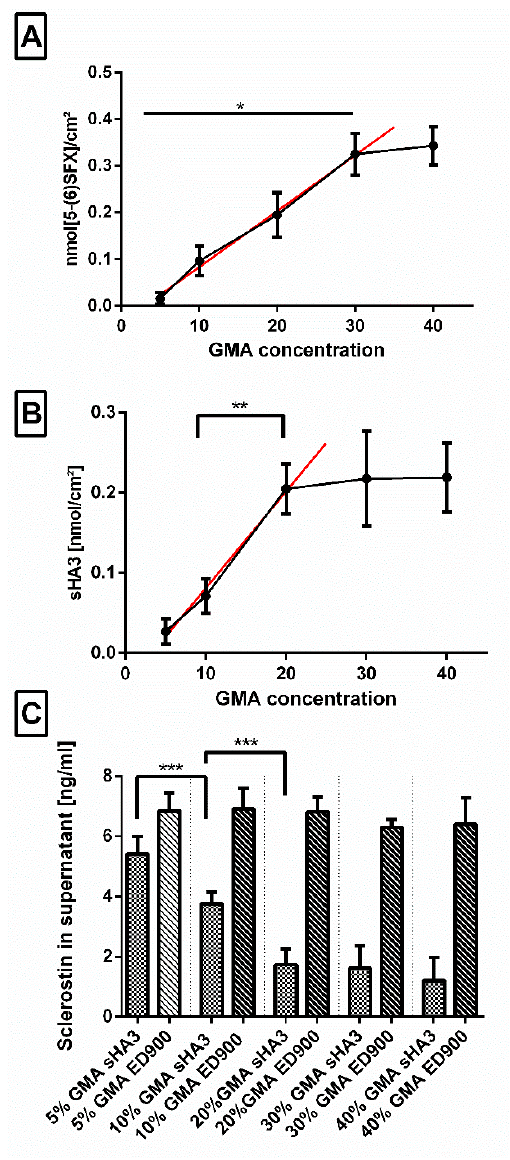
Figure 7. Effect of increasing concentrations (5–40% m/m ) of GMA anchor incorporated during cross- copolymerization. Impact on ( A ) linker surface decoration, measured via 5-(6)SFX staining, ( B ) subsequent functionalization with fluorescent-labeled sHA3, and ( C ) scavenging capability of the sHA3 and ED900 control surfaces is shown. Film surfaces: ED900: ED900 incubated with soluble sHA3; sHA3: ED900 covalently coated with sHA3. Linear regression ( A ) R 2 = 0.92, slope = 0.011, y -intercept = − 0.037; (B) R 2 = 0.90, slope = 0.012, y -intercept = − 0.040. All values represent the mean ± SD of n ≥ 4. * p < 0.05; ** p < 0.01; *** p < 0.001 denotes significant difference vs. the respective formulations.